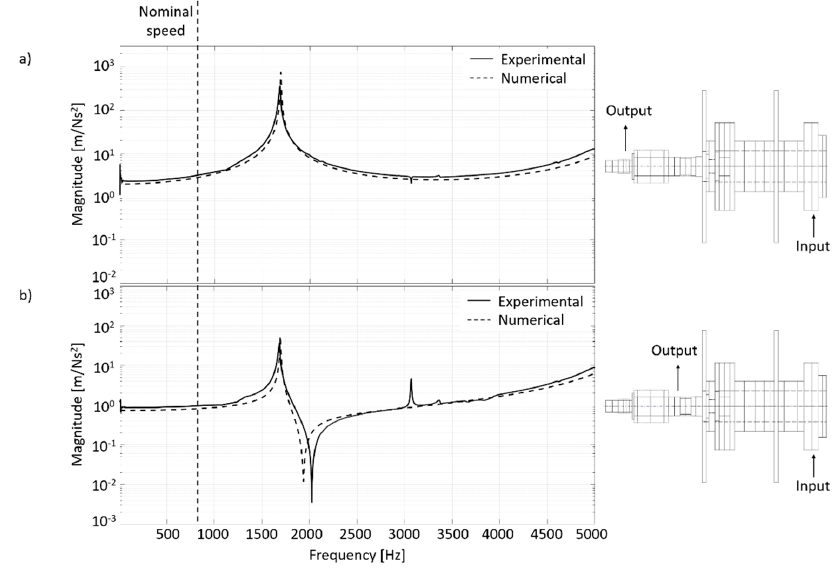
Figure 10. Rotor characterization. Transfer functions measured between the force on the higher part of the impeller mock-up (input) and the acceleration in correspondence of the SES ( a ) and CS ( b ) damper